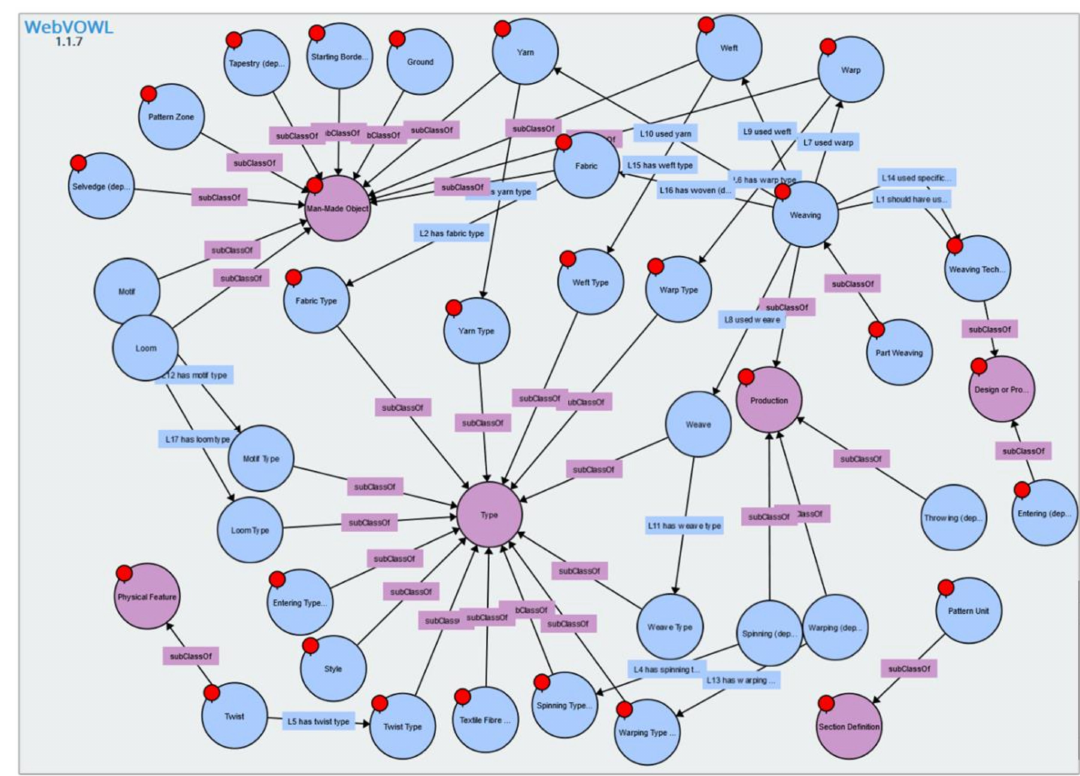
Figure 1. Overview of SILKNOW’s ontology. Image generated with the WebVOWL (Web-based Visualization of Ontologies) viewer, integrated in the Ontome web page